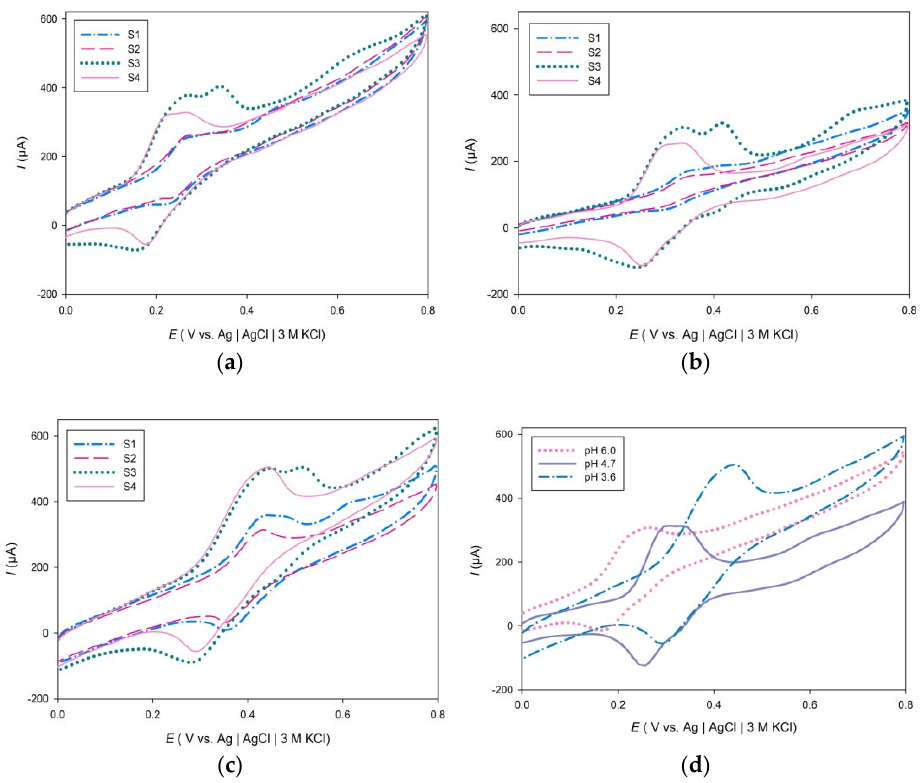
Figure 2. Cyclic voltammograms of aqueous plant extracts (S1 − S4) in different buffer solutions pH 6.0 ( a ), pH 4.7 ( b ), pH 3.6 ( c ). Cyclic voltammogram of M. piperita (S3) in three buffer solutions ( d ) recorded at a scan rate of 100 mV s − 1